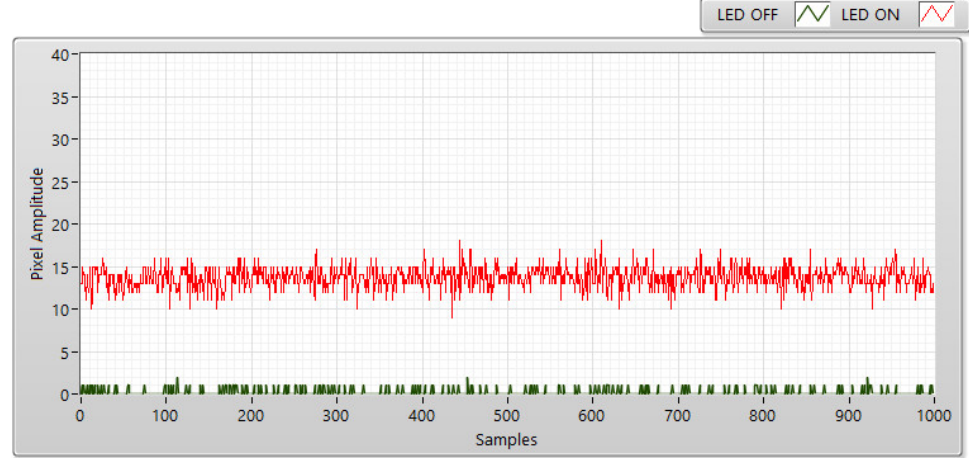
Figure 7. The SNR measurement using a rolling-shutter camera at 10 m and a 50 μs exposure-time setting.